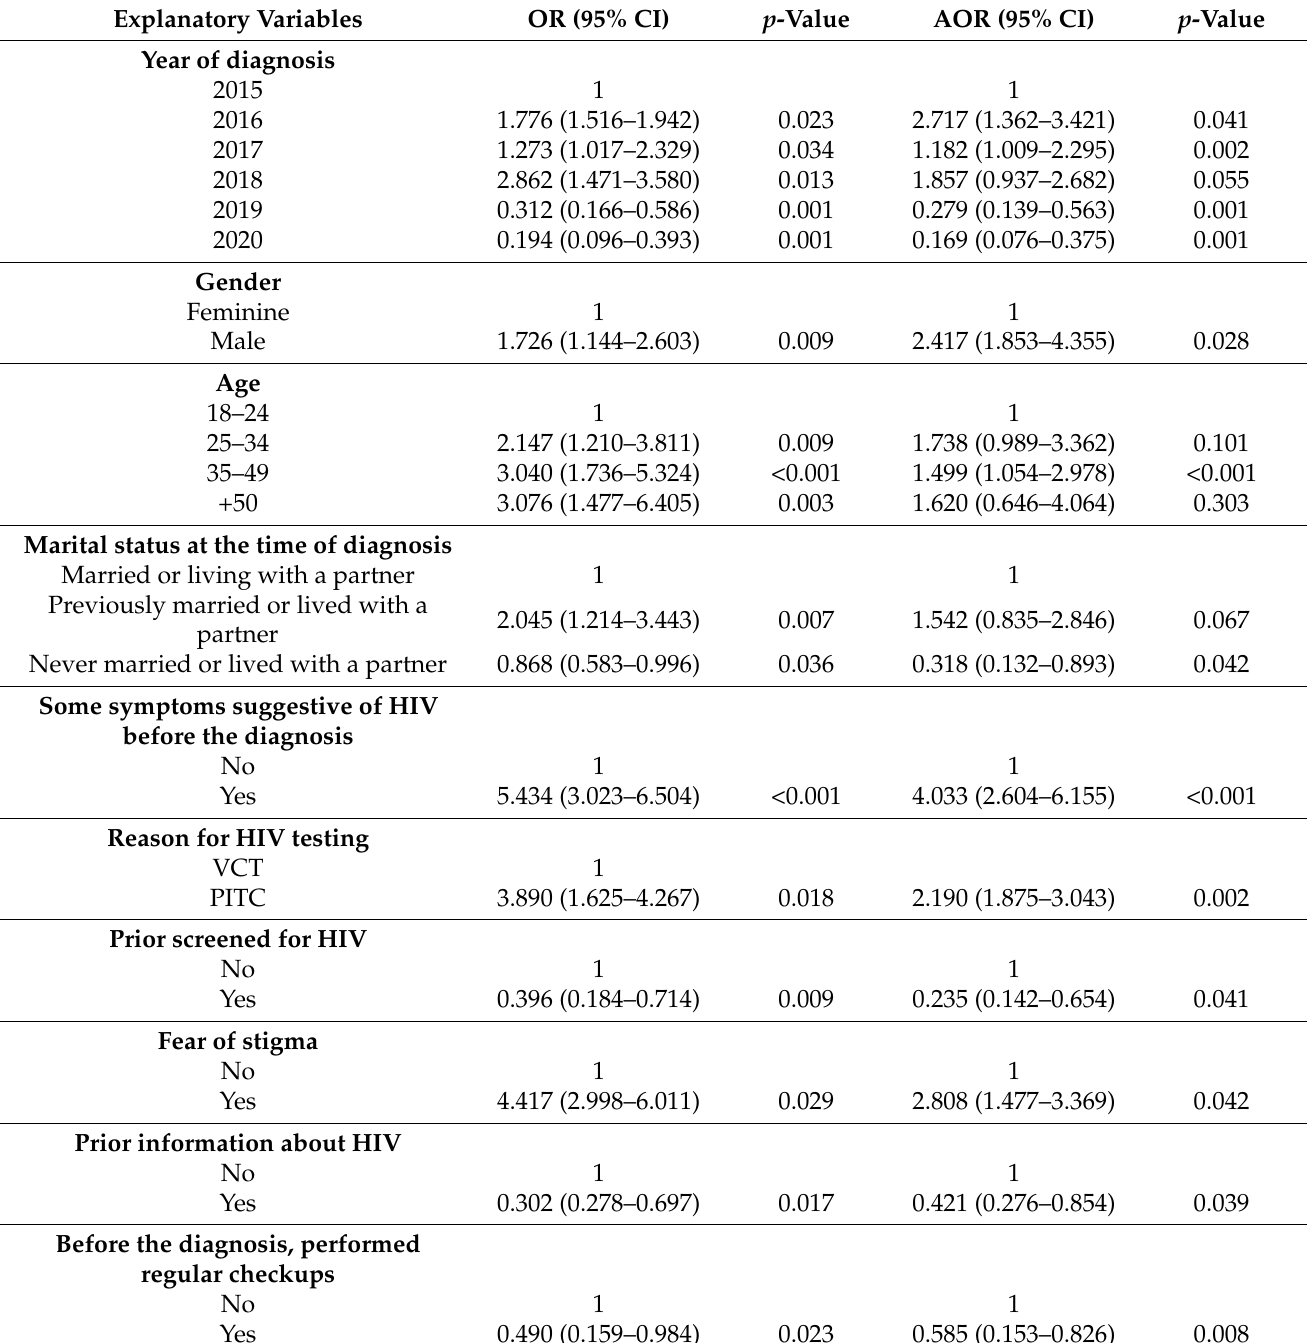
Table 3. Multivariate results (AOR and OR) for variables associated with late HIV diagnosis at the Ndlavela Health Center,